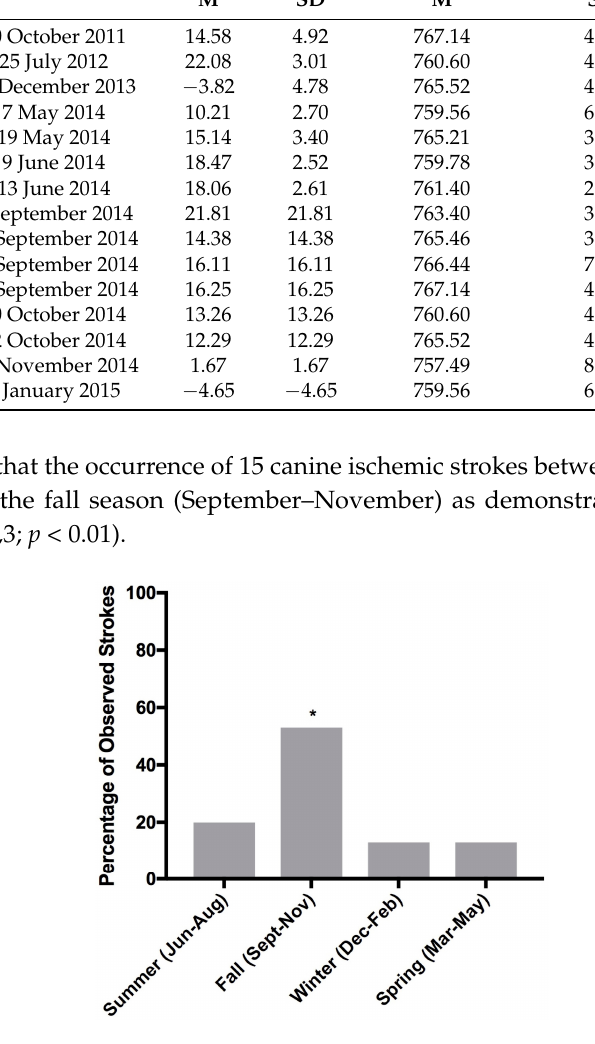
Figure 1. Histogram of the percentage of observed canine ischemic strokes ( n = 15) between 2011 and 2015 by season (chi-square, df; 18.18,3 * p < 0.01).